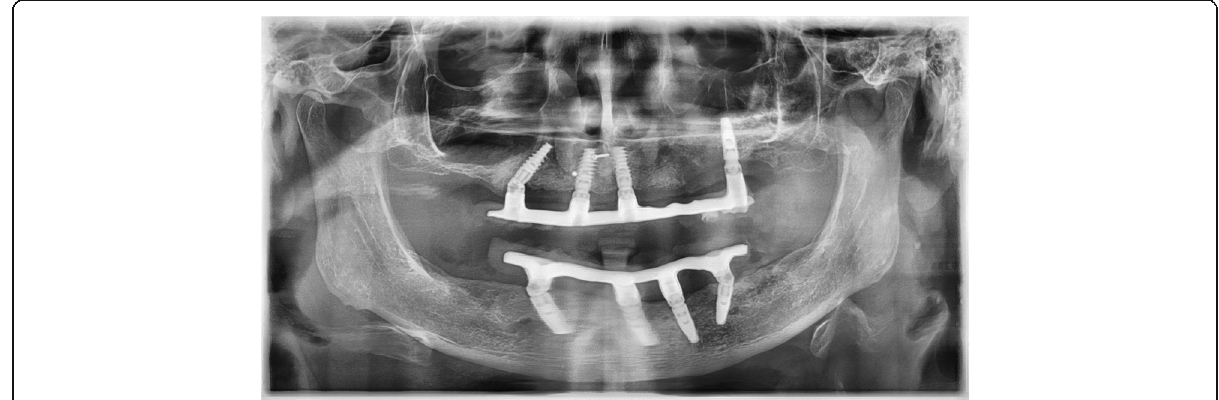
Fig. 4 This X-ray records the integration of the redesigned restoration of the case in Figs. 2 and 3. The loosened implant was